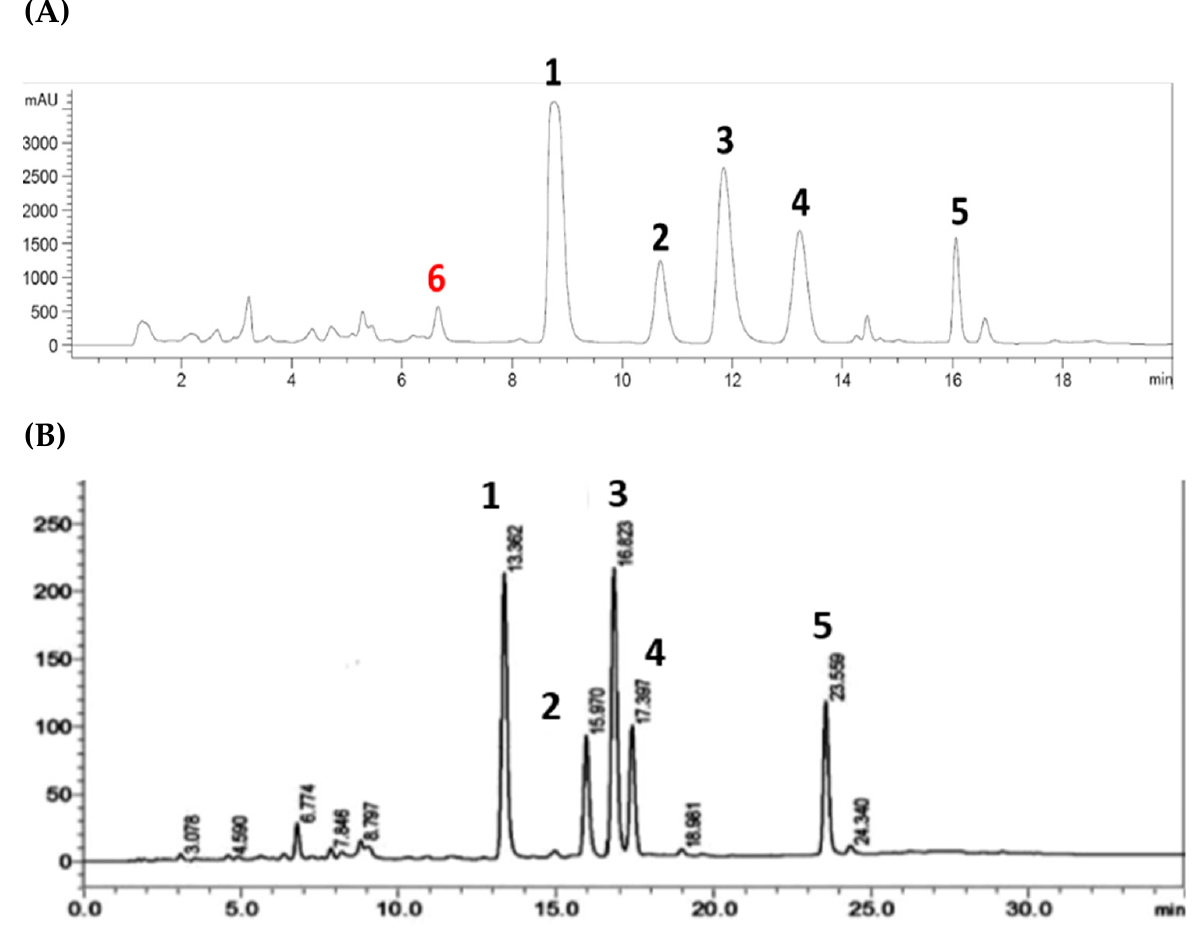
Figure 5. HPLC chromatograms of the Australian propolis extract in this study ( A ) and Taiwanese green propolis extract ( B ) (adapted from Chen et al. [67] ) recorded at 280 nm.